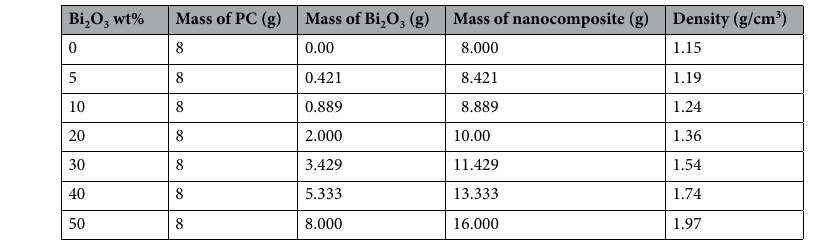
Table 2. Measured amounts of PC and Bi 2 O 3 to prepare nanocomposites.